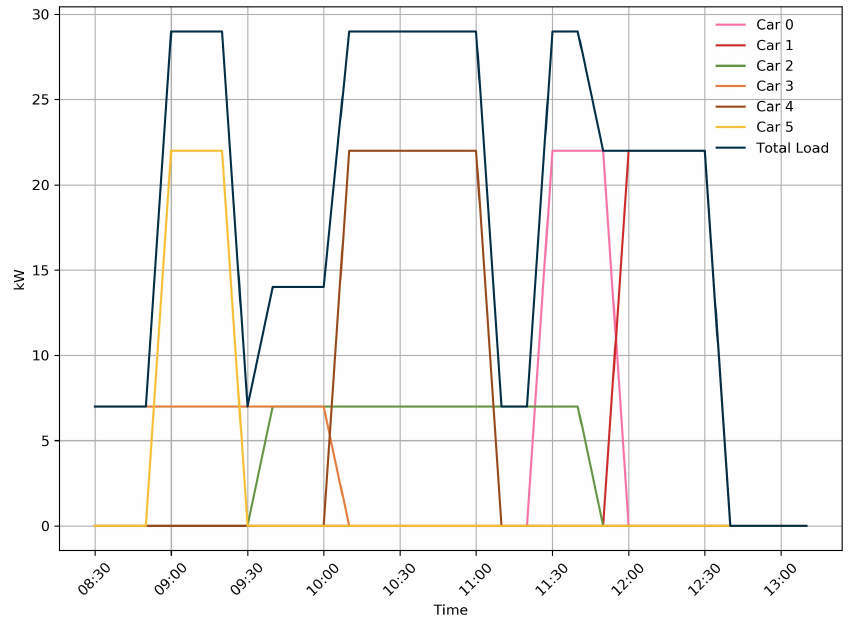
Figure 13. Vehicle recharging schedule for the profile in Figure